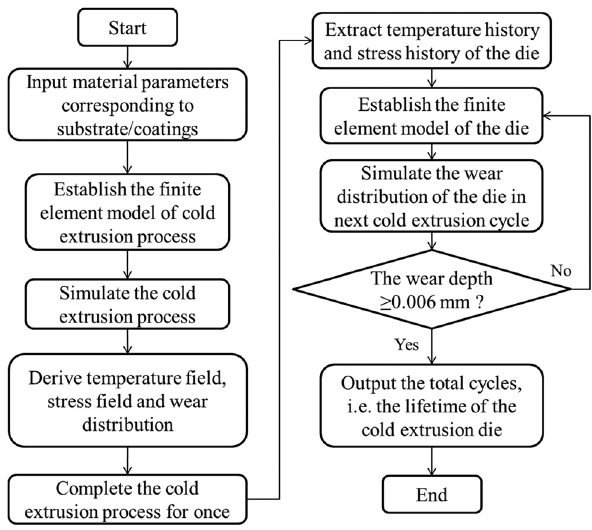
Figure 12: Finite element simulation procedures of the die lifetime for cold extrusion process.